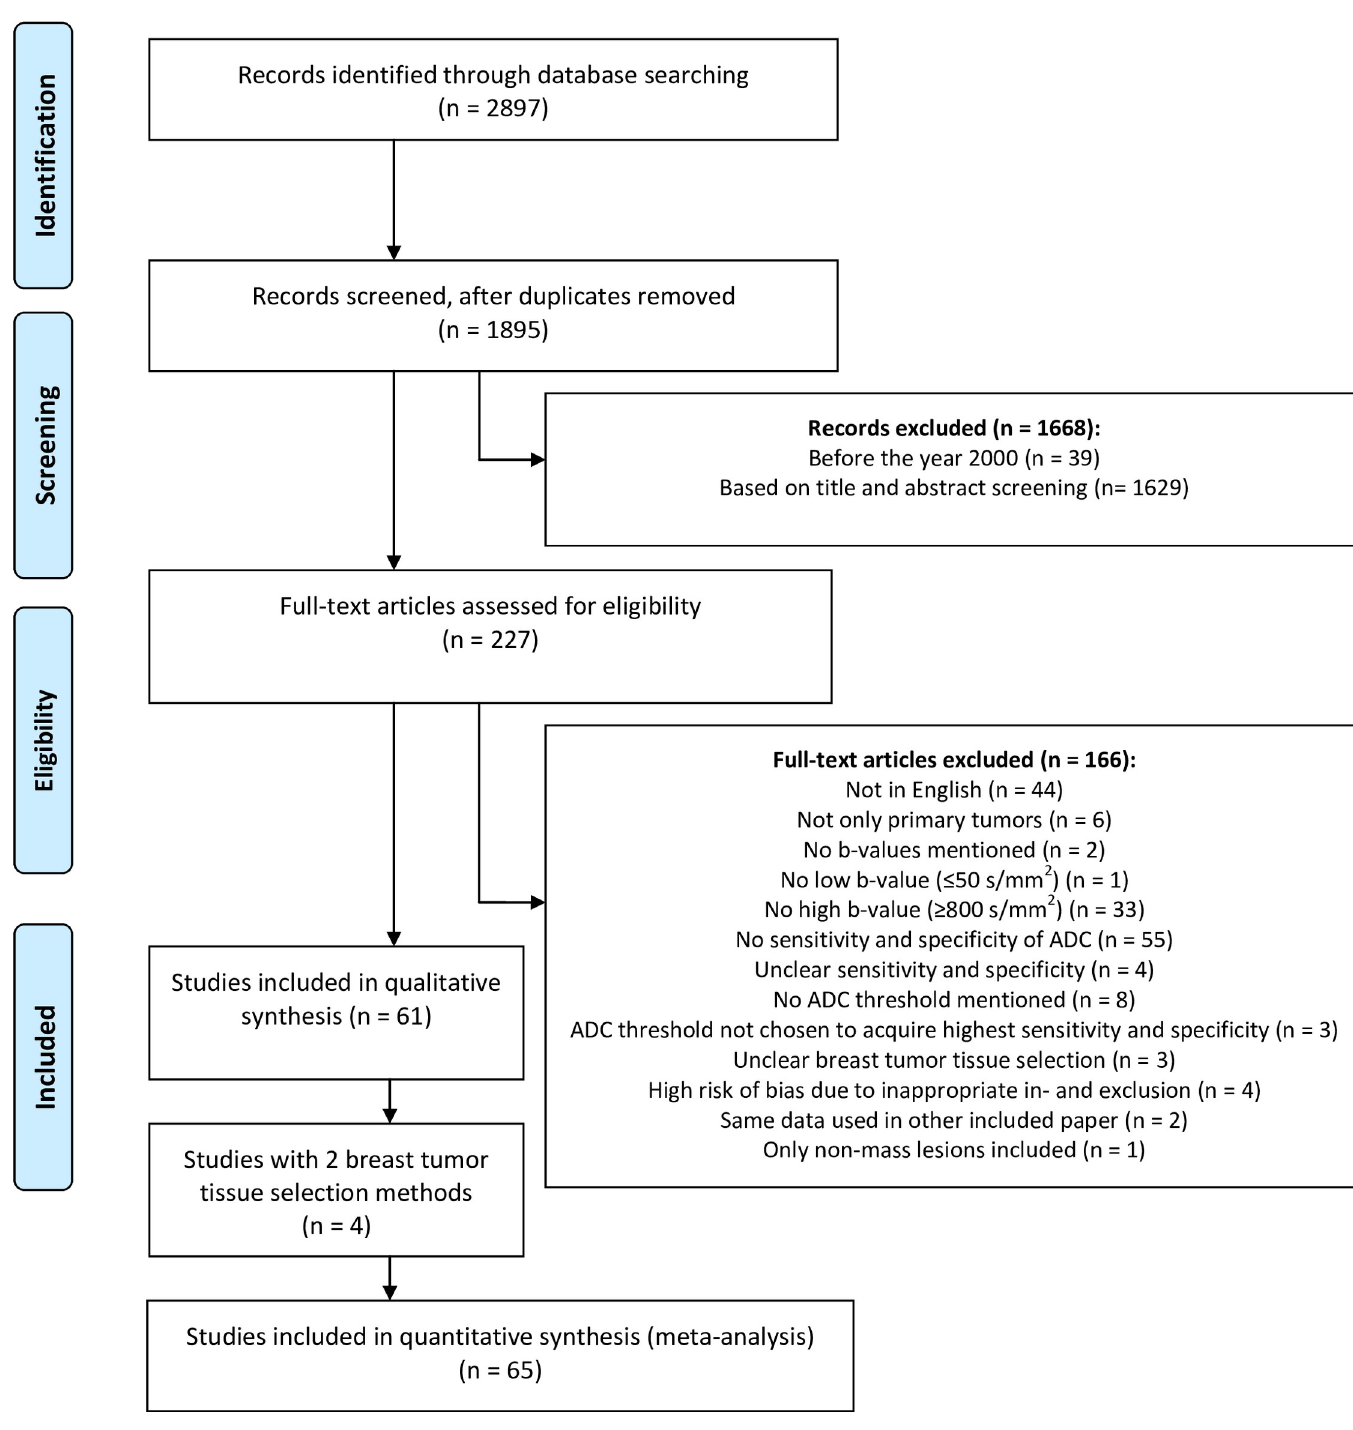
Fig 1. Flowchart of the study selection process, reasons for excluding papers and numbers of excluded and included papers. ADC = apparent diffusion coefficient, BTTS = breast tumor tissue selection.